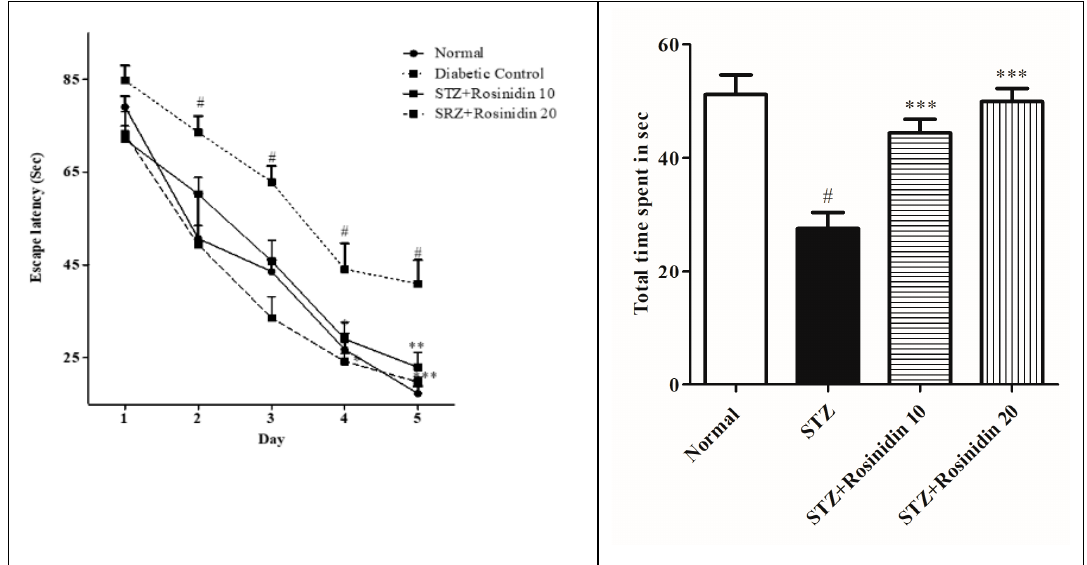
Figure 3. The effect of rosinidin on the Morris water maze test. All the values are presented as the mean ± SEM. Correlation among the groups was done using two-way ANOVA. p value < 0.01, 0.001 were expressed as **, *** respectively as compared to the streptozotocin (STZ) group. p < 0.001 were expressed as # when compared with the controls.